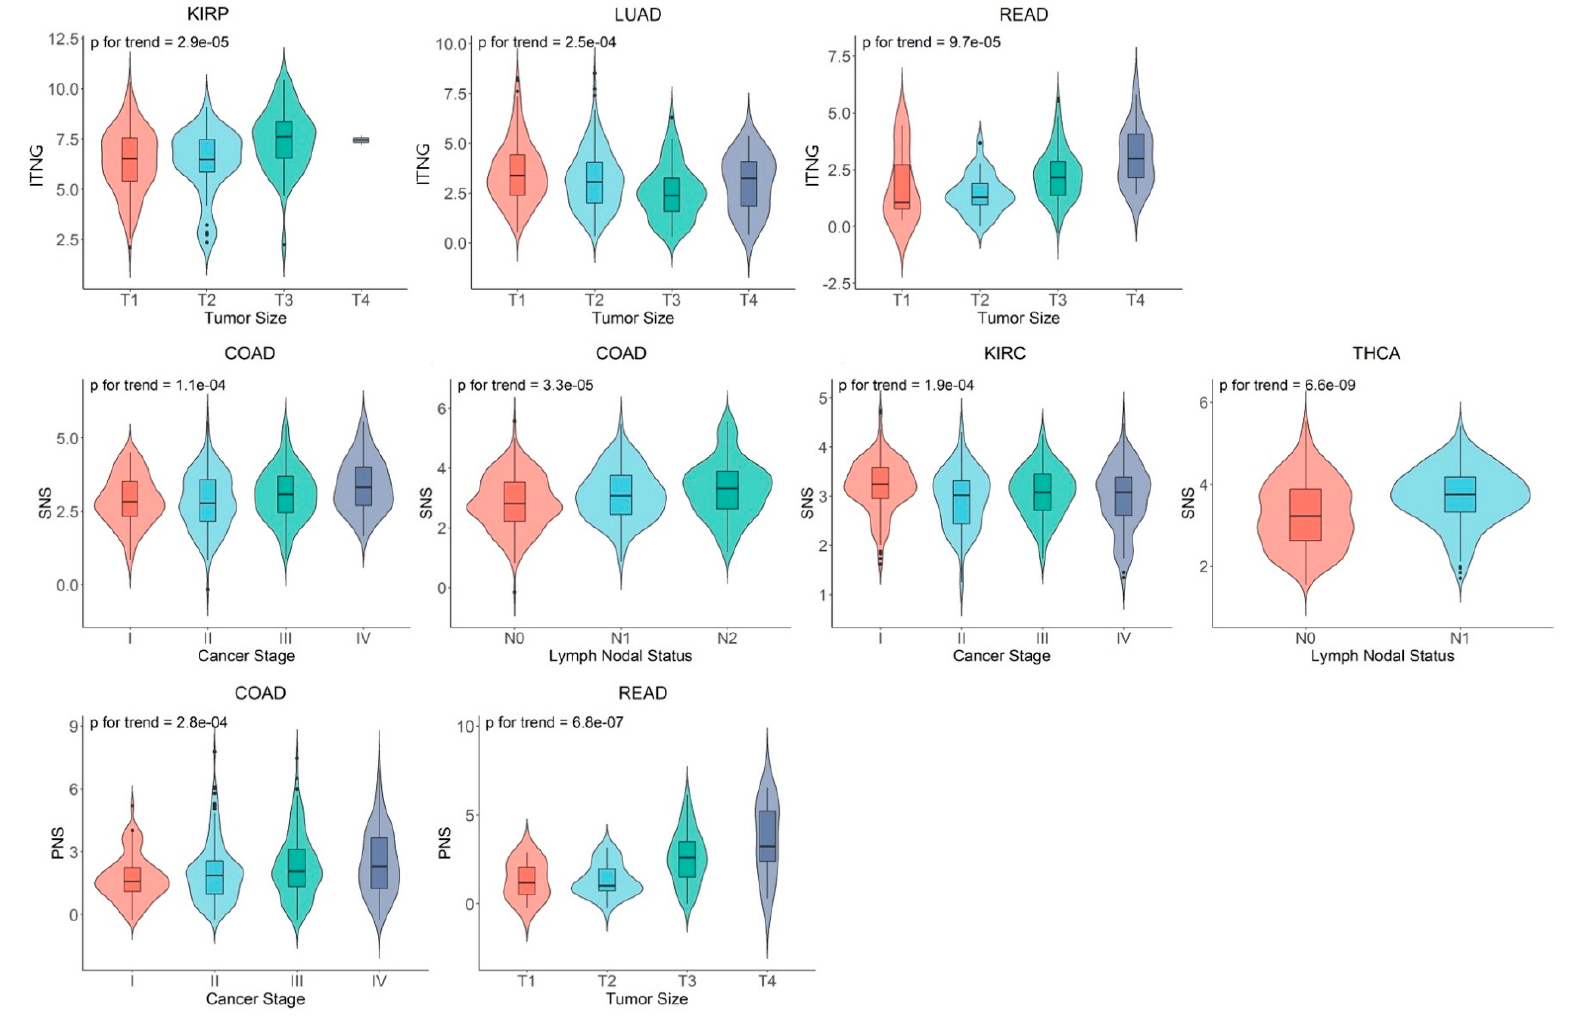
Figure 3. Autonomic nervous system gene expression signatures by tumor histopathological features.